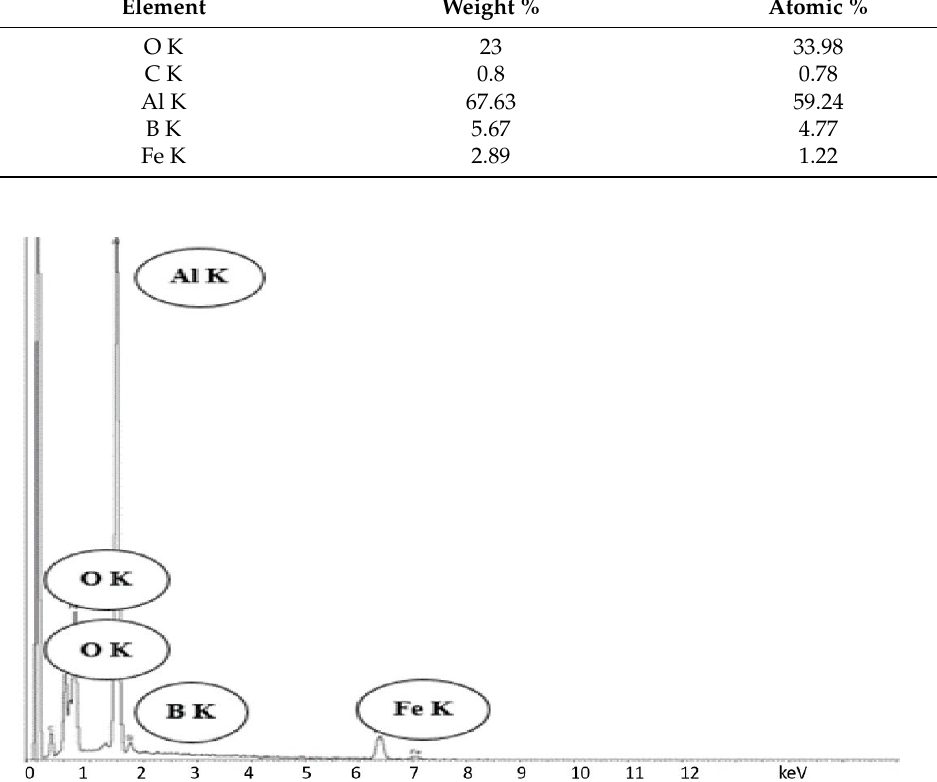
Figure 12. EDX analysis spectrum at point B in specimen welded at normal conditions. Table 9. EDX quantitative analysis data at point B in specimen welded at normal conditions.